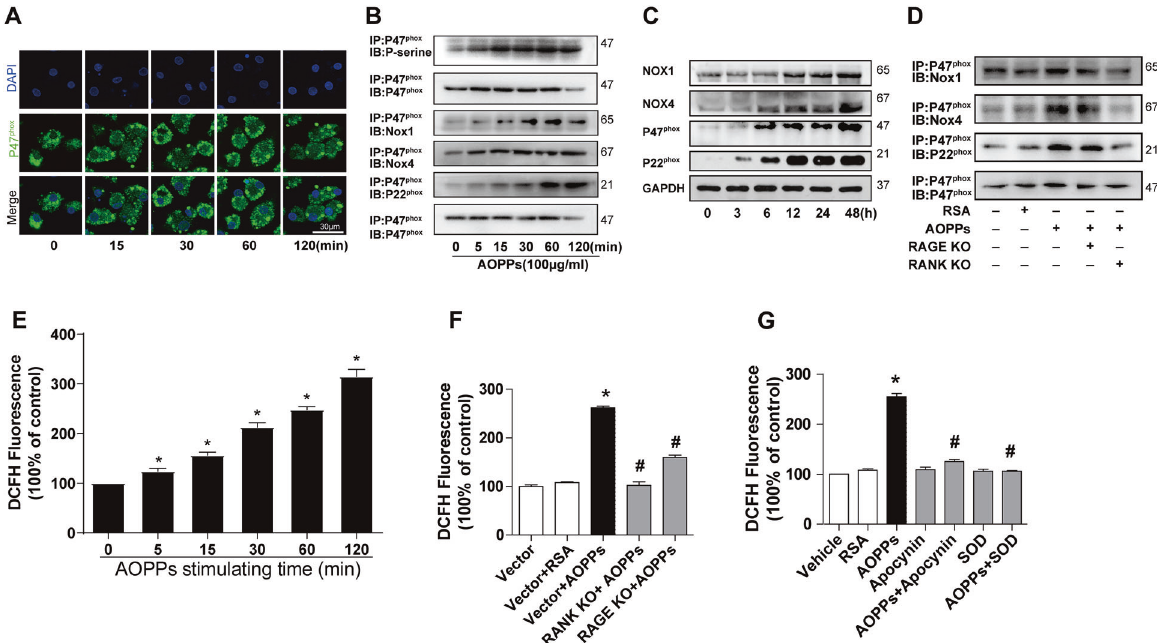
Fig. 4 AOPPs activated NADPH oxidase and increased intracellular ROS generation by RANK and RAGE signaling. A BMMs were treated with AOPPs for 0, 15, 30, 60, 120 min, then p47 phox were measured by immuno fl uorescence staining. Representative confocal microscope images of AOPP-induced membrane translocation of p47 phox . Scale bars = 30 µm. B Co-immunoprecipitation analysis showed that AOPP treatment enhanced the binding of p47 phox to Nox1, Nox4, and p22 phox . C Western bolting analysis revealed that AOPPs treatment increased expression of NADPH oxidase subunits Nox1, Nox4, p22 phox and p47 phox . D Co-immunoprecipitation analysis showed that the enhanced binding of p47 phox to Nox1, Nox4, and p22 phox induced by AOPPs were inhibited after knockdown of RANK or RAGE. E Intracellular ROS was detected by DCFH-DA. AOPPs treatment induced intracellular ROS generation. F , G AOPPs-induced ROS generation were signi fi cantly blocked after knockdown RANK or RAGE or pre-treatment with apocynin (100 μ M, a NADPH oxidase inhibitor) or SOD (50 U/ml, a radical scavenger superoxide dismutase). Representative images of three view fi elds of per experiment were shown. Each co-IP was performed three times experiments and blotted separately each time. Data were presented as mean ± SD. * p < 0.05 versus the vehicle-treated group. # p < 0.05 versus AOPPs-treated signaling axis following AOPPs stimulation. AOPPs-induced form of TRAP positive cells (Fig. 7A, B), increase of TRAP activity (Fig. 7C), expression of TRAP, MMP9, cathepsin K, and Oscar gene (Fig. 7D) were signi fi cantly suppressed by NADPH oxidase inhibitor apocynin, ROS scavenger SOD, JNK inhibitor SP600125, ERK1/2 inhibitor U0126, and p38 inhibitor SB20358. Further- more, the formation of F-actin rings (Fig. 7E) and bone- resorption pits (Fig. 7F) were also decreased after treatment of the above inhibitors.